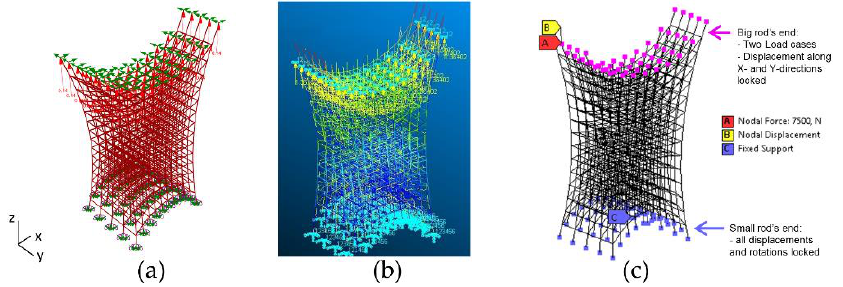
Figure 4. Boundary condition of the traction load case: ( a ) Karamba3D, ( b ) Nastran, and ( c ) ANSYS Mechanical. Table 2. Material properties of AlSi10Mg produced by SLM technology